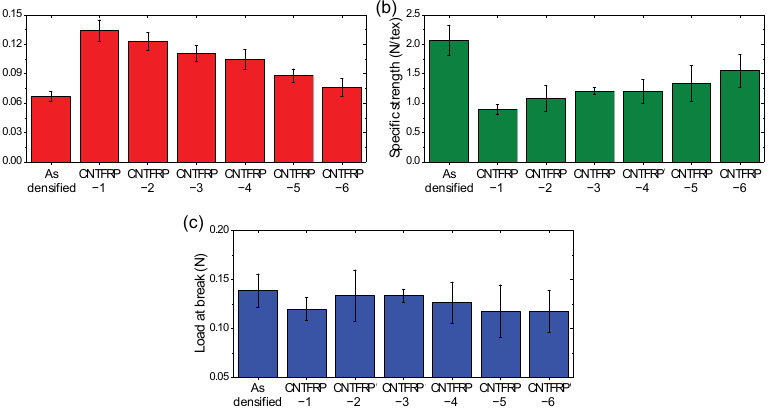
Figure 4. ( a ) Linear density, ( b ) specific strength, and ( c ) load-at-break value of the as-densified CNTF and composite fibers.